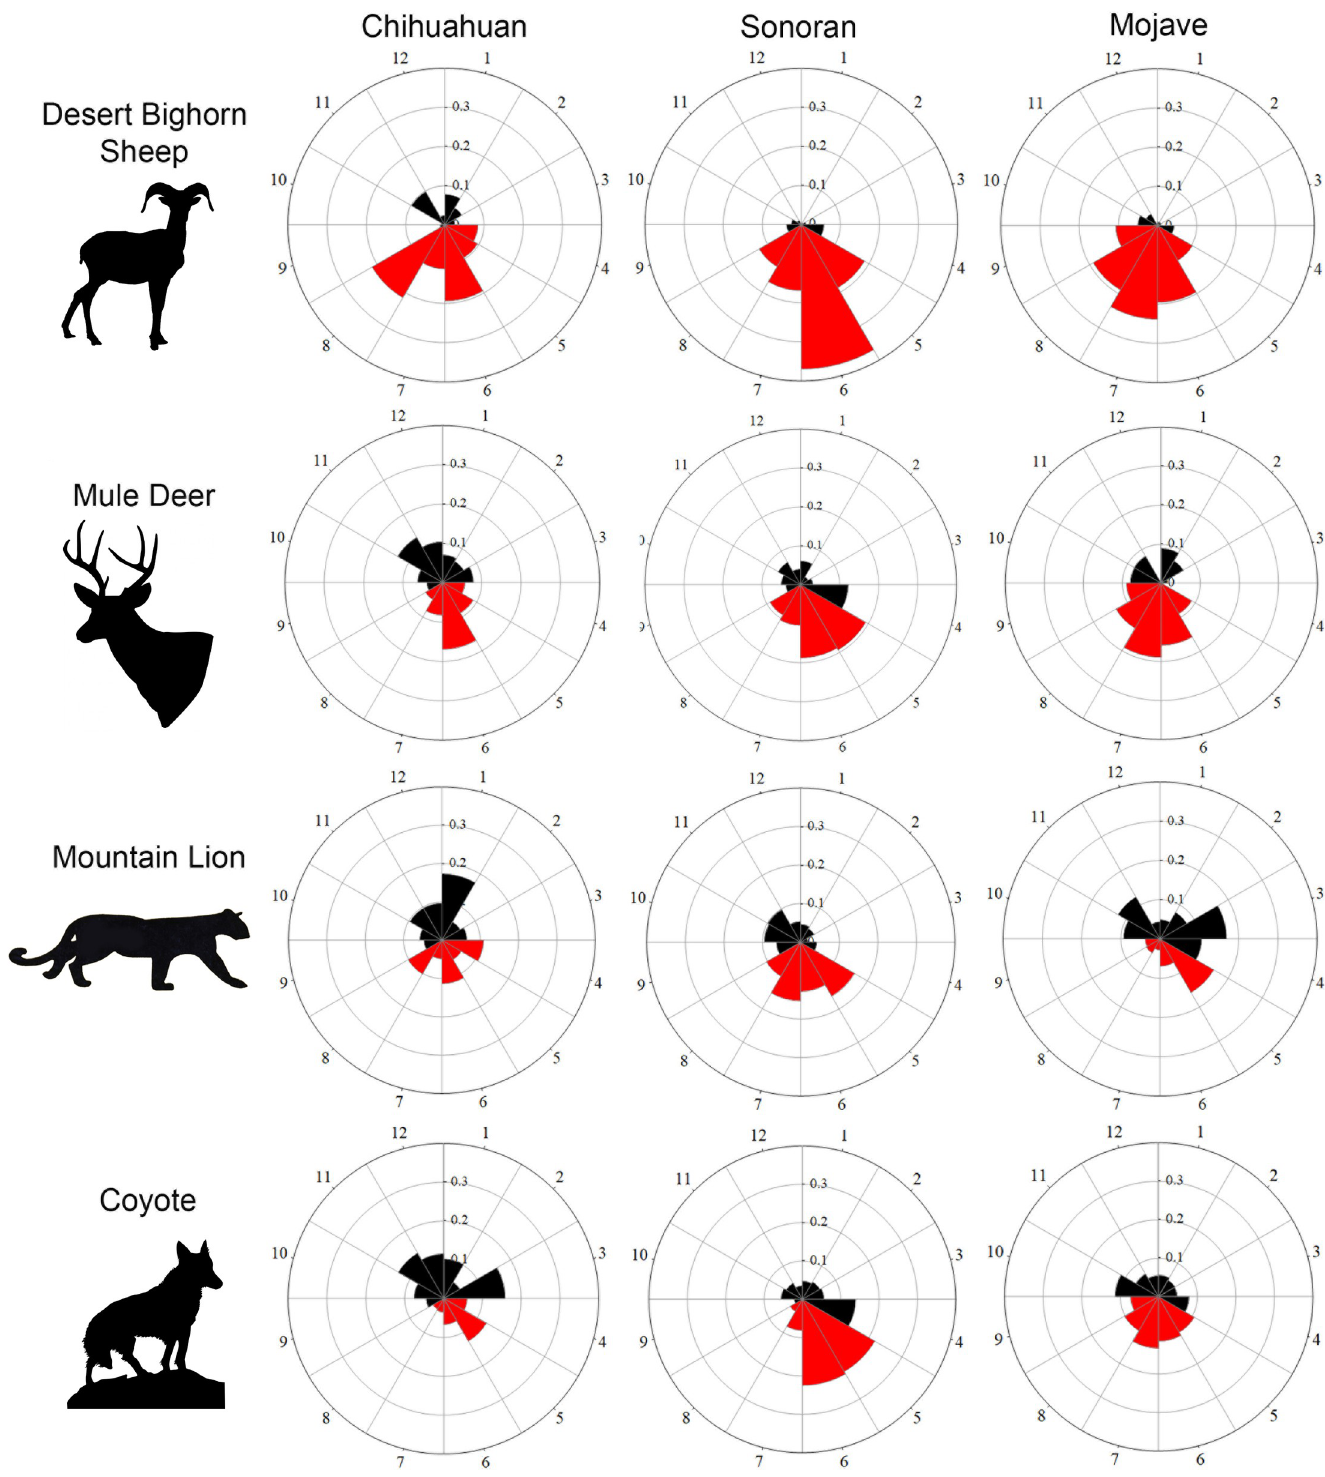
Fig 2. Polar plots describing the timing of species visits. Plots report the mean proportion of visits to water catchments per month for 4 species across 3 deserts (data pooled across sites and years within a desert). For all plots, red indicates the 4–5 contiguous months receiving the most visits for desert bighorn sheep (January- December (shown as 1–12)). Black indicates the months receiving the least amount of visits to water catchments by bighorn sheep. Bighorn concentrate visits to a 4–5 month period, while both carnivores and mule deer visit water catchments generally year-round. Species silhouettes from [https://www.needpix.com/] under